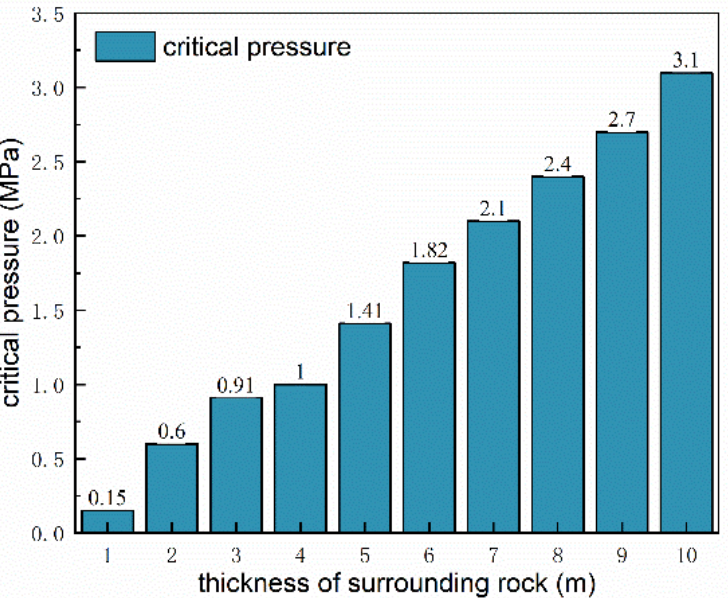
Figure 15. Comparison of water pressure resistance of different surrounding rock thicknesses.